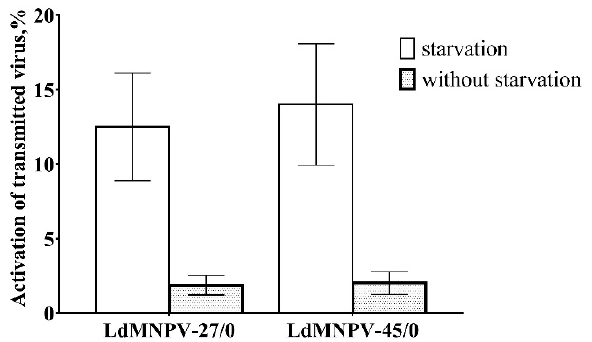
Figure 2. The frequency of activation of vertically transmitted virus in offspring of Lymantria dispar parents infected by low (LdMNPV-27/0) and high (LdMNPV-45/0) virulent strains.